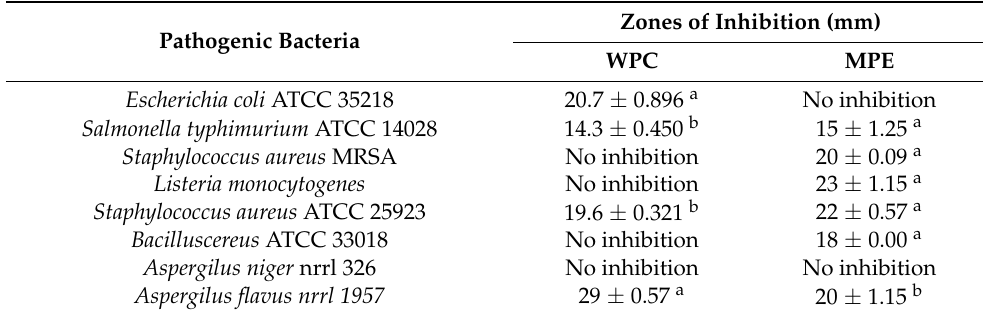
Table 3. Antimicrobial activity of whey protein concentrate (WPC) and mango peel extract (MPE) against 8 clinical pathogenic